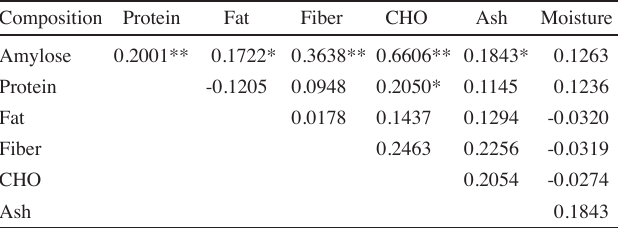
Tab. 3: Estimates of phenotypic correlation coefficients between seven nutrient compositions in aromatic rice. Composition Protein